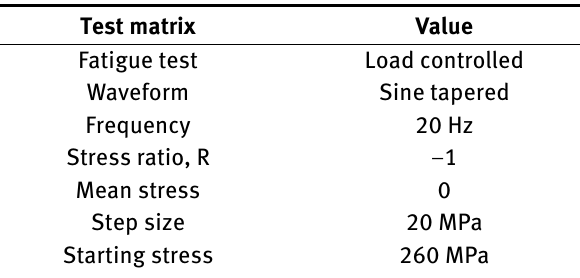
Figure 2: Specimen and jig configuration on servo hydraulic equip- ment. Table 1: Test matrix for fatigue strength evaluation by staircase